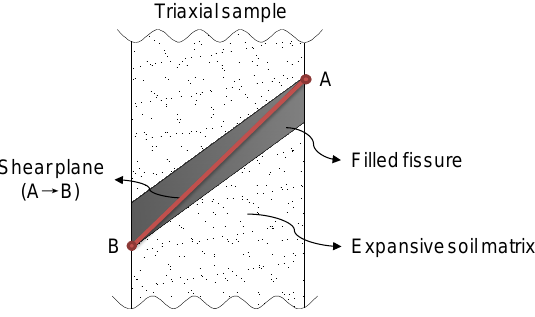
Figure 7. The shear failure characteristics of the sample along the diagonal of the filled fissure.